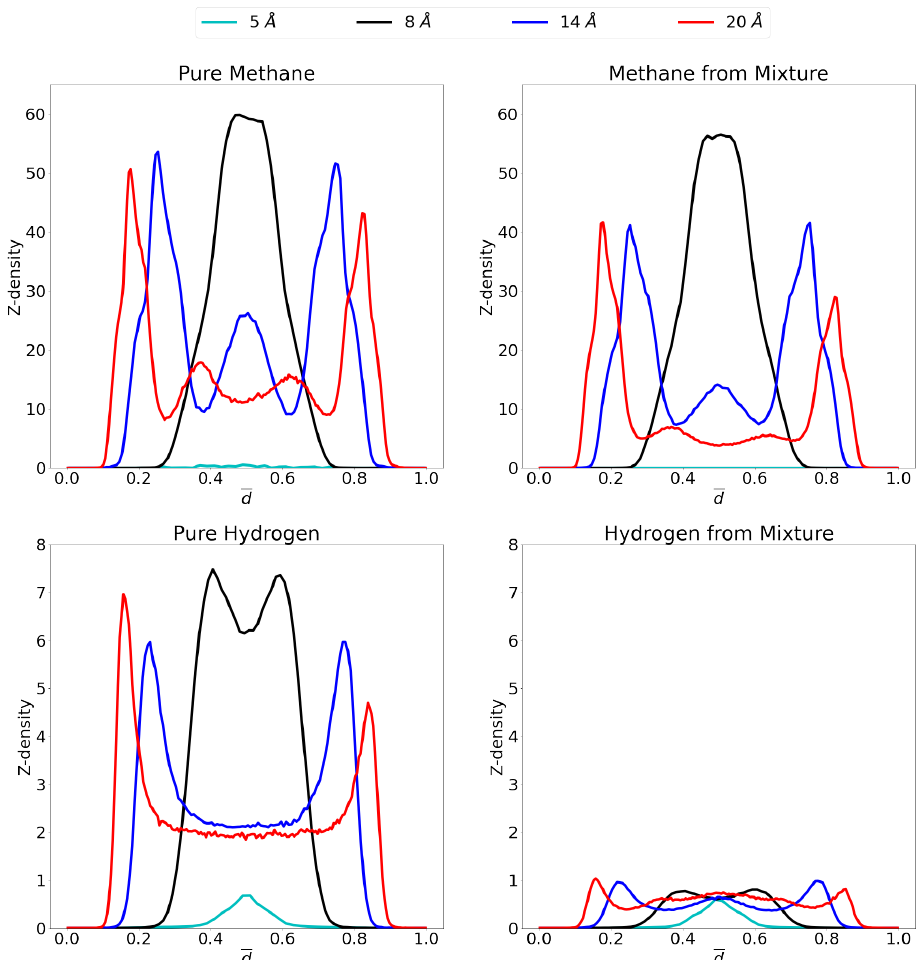
Figure 7. Z-density profiles at 70 atm for pure methane ( top left ), methane in the mixture ( top right ), pure molecular hydrogen ( bottom left ) and molecular hydrogen from the mixture ( bottom right ) in the different considered pores at 300 K. Reduced distance units are used so that the graphene sheets of the pores are located at 0 and 1 on the x-axis. Please notice the different scales on the